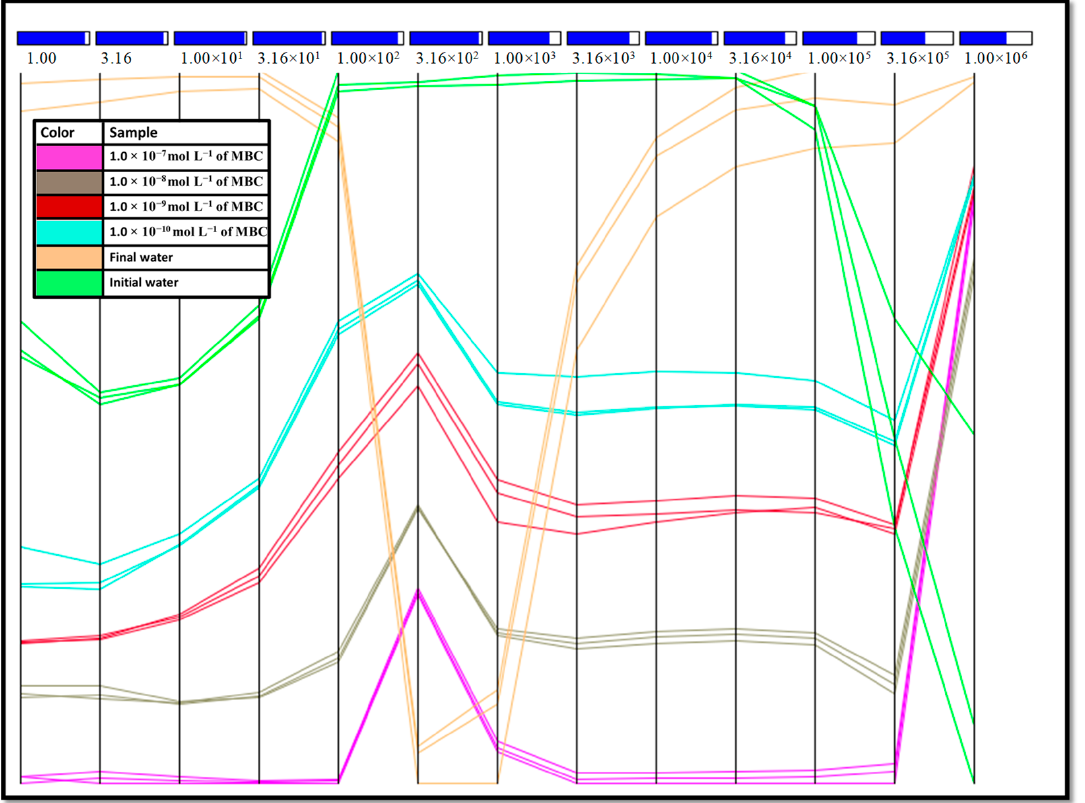
Figure 7. Parallel coordinates plot for the σ ac data obtained with the sensing units made with (DODAB/NiTsPc) 5 LbL film using three measurements for each concentration. IDE 10.